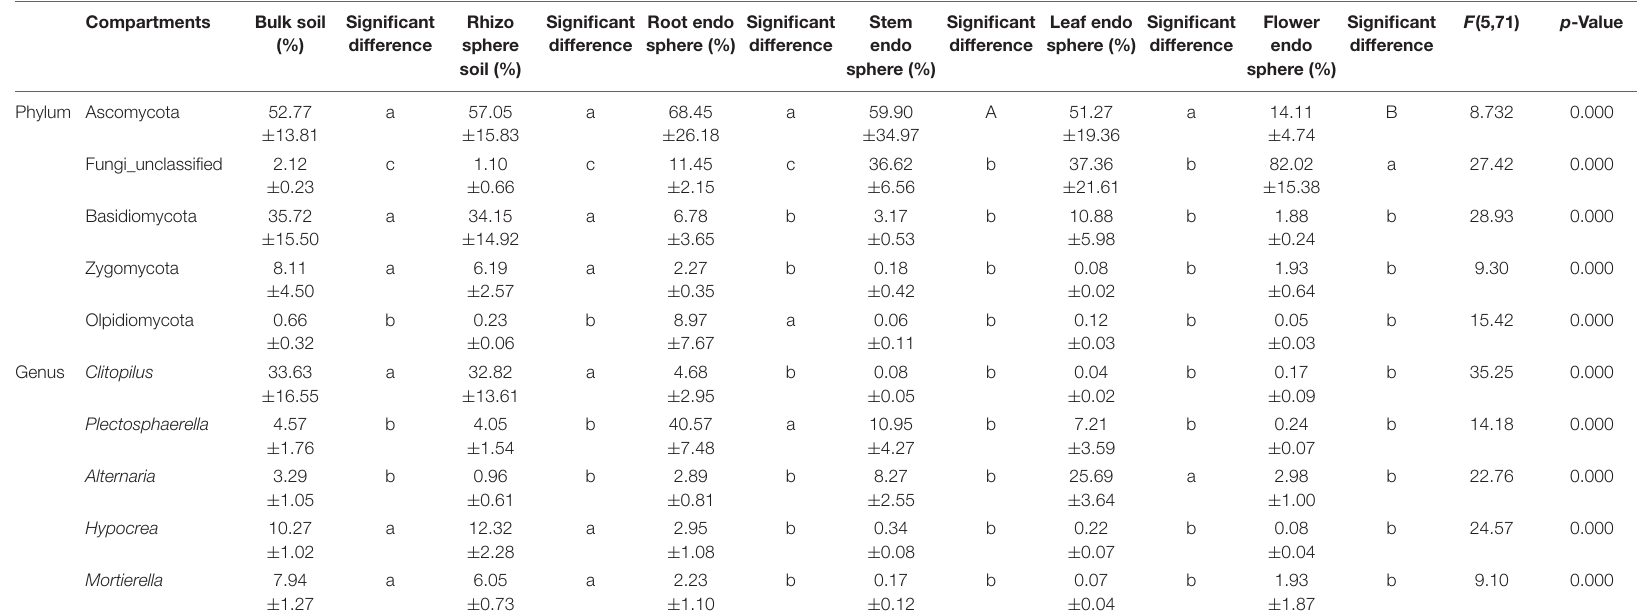
TABLE 2 | The top five most abundant fungal communities within compartments in hemp plants ( x ± SD). Compartments Bulk soil